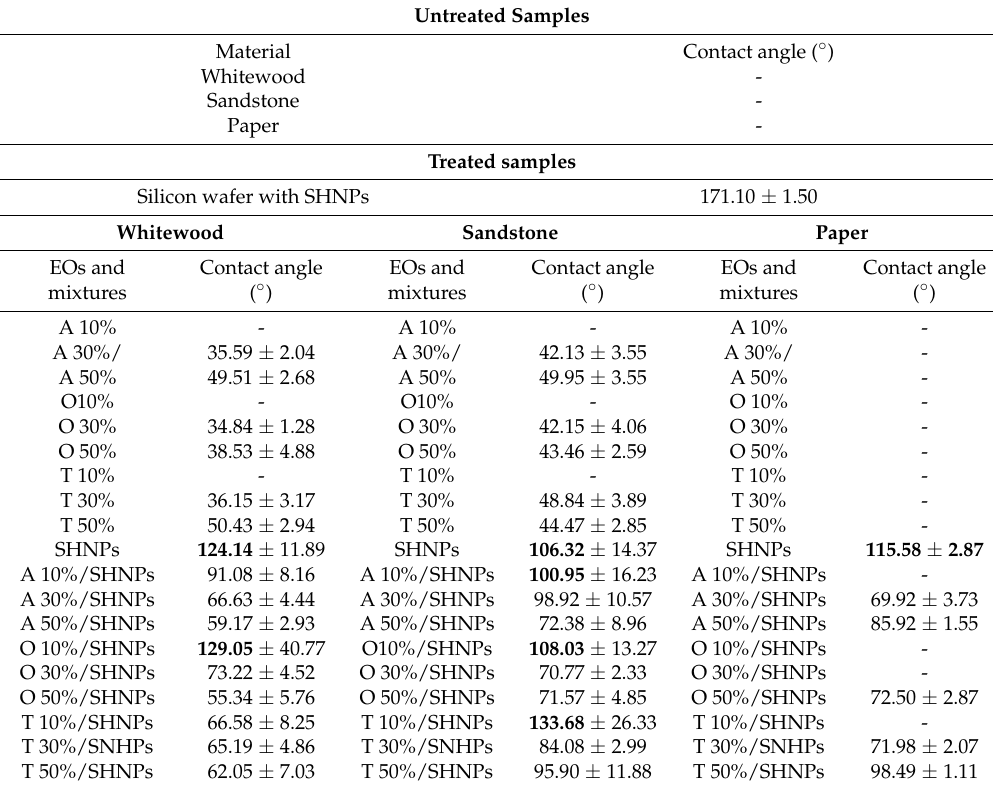
Table 2. Contact angle measurements of EOs, SHNPs, and SHNP/EO mixtures on different material